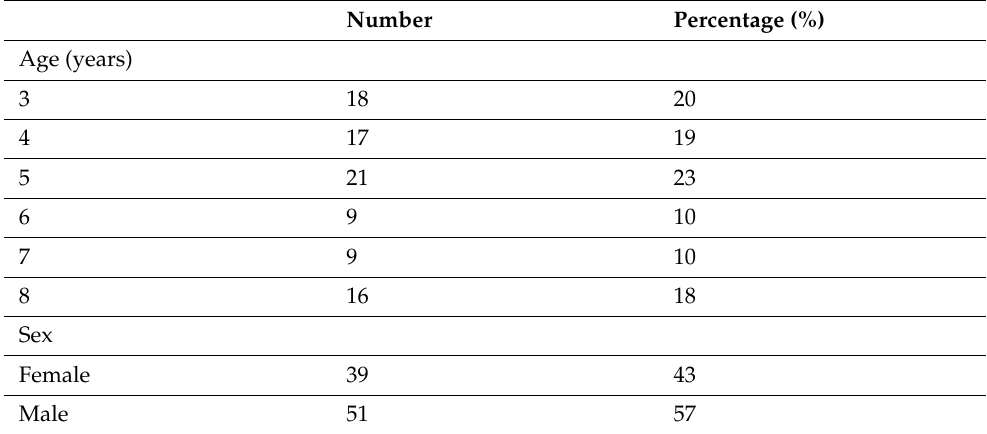
Table 1. Demographic characteristics of the population: information on the 90 participants